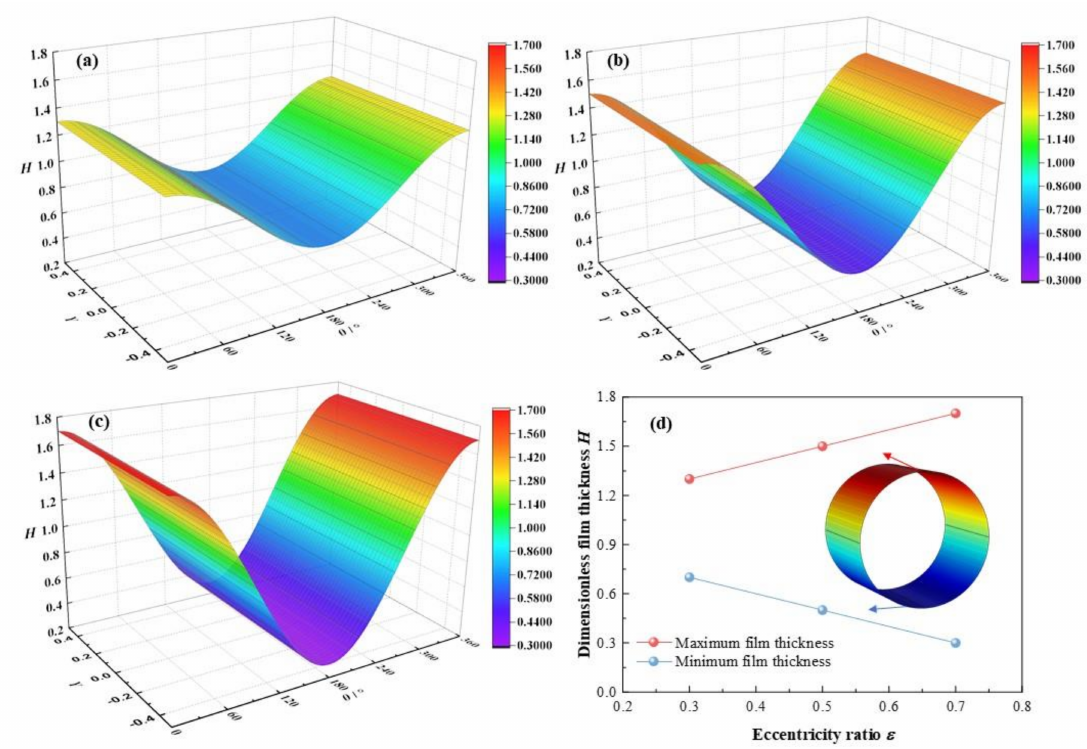
Figure 6. Comparison of the film thickness distribution under different eccentricity ratios. ( a ) ε = 0.3; ( b ) ε = 0.5; ( c ) ε = 0.7; ( d ) maximum/minimum film